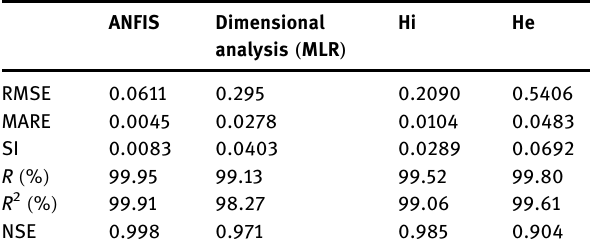
Table 2: Results realization for discharge calculated in di ff erent methods